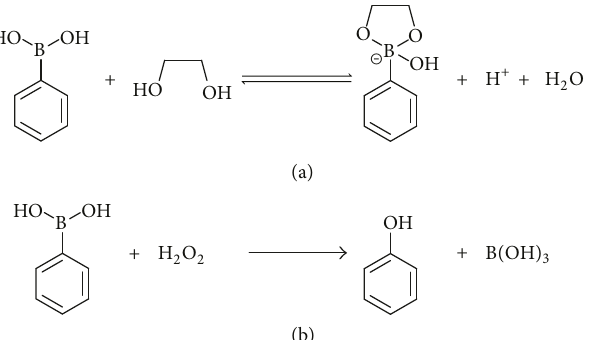
Scheme 1: Reaction of boronic acid with saccharide (a) and hydrogen peroxide (b).